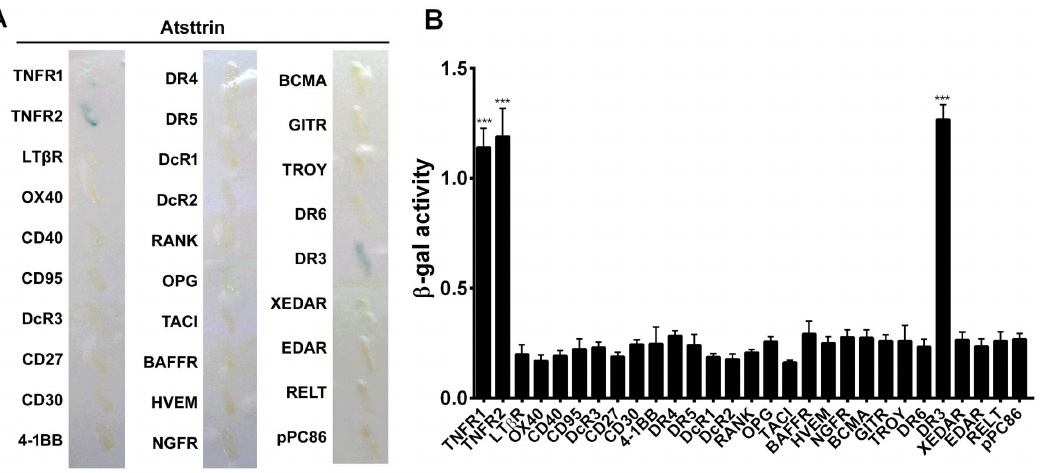
Figure 1. Atsttrin specifically binds to TNFR and DR3 in TNFR super family. A. cDNA encoding Atsttrin was fused to the Gal4 DNA binding domain in the pDBLeu vector and cDNAs encoding the extracellular portions of 28 TNFRSF members were fused to the Gal4 activation domain in the pPC86 vector. Selected plasmids were co-transformed into yeast strain MAV203; X-Gal assay was performed to determine b -galactosidase phenotype. B. Quantitative assay for b -galactosidase ( b -gal) activity in liquid cultures of the interactions between Atsttrin and TNFR superfamily members were determined using o-nitropenyl- b -D-galactopyranoside (ONPG) as a substrate. For each strain, three independent colonies were analyzed and triplicate samples for each colony. pPC86 empty vector was used as a negative control. ***p , 0.001 versus negative